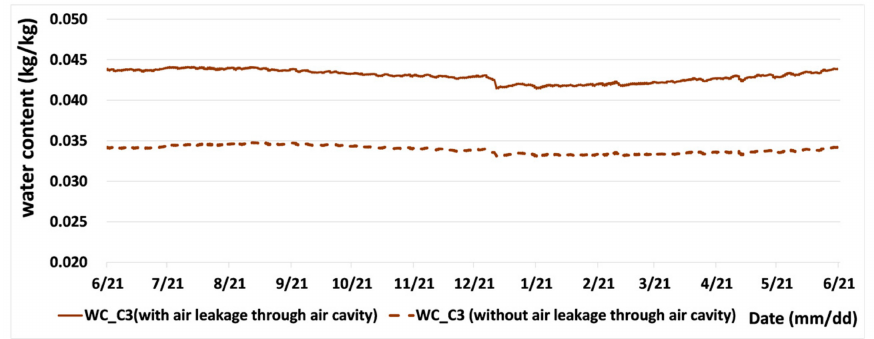
Figure 23. Calculated water content of the upper cavity cells (C3) in the cases with / without air leakage through air cavity.